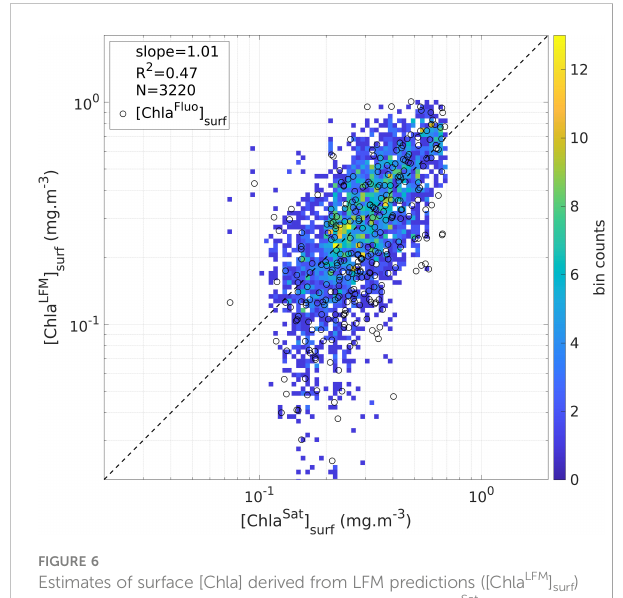
FIGURE 6 Estimates of surface [Chla] derived from LFM predictions ([Chla LFM ] surf ) compared to satellite estimates of surface [Chla] ([Chla Sat ] surf ). The color of the pixels represent the density of the points in the plot (in total: 3 320 matchups are displayed). The dashed black line materializes the linear regression including all matched samples of [Chla LFM ] surf and [Chla Sat ] surf (slope = 1.01; R 2 = 0.47; N = 3 320 matchups). The black circles represent the available concomitant values of [Chla Fluo ] surf (N = 329 successful matchups within the 1 387 [Chla Fluo ] pro fi les used to construct the model, see Section